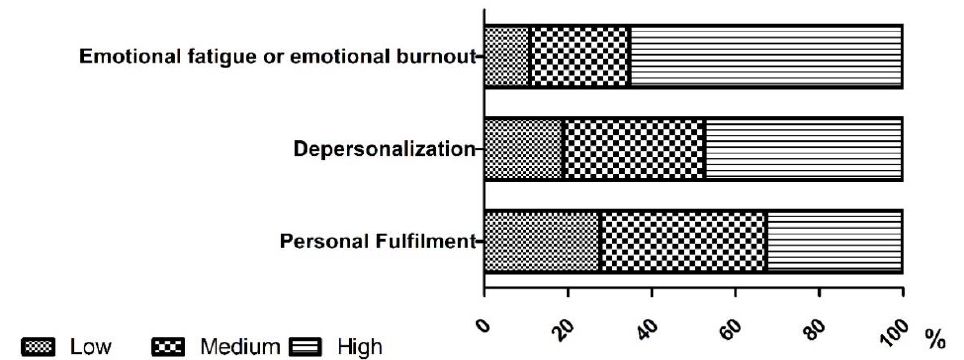
Figure 1. Categorization of burnout risk in each of its dimensions.